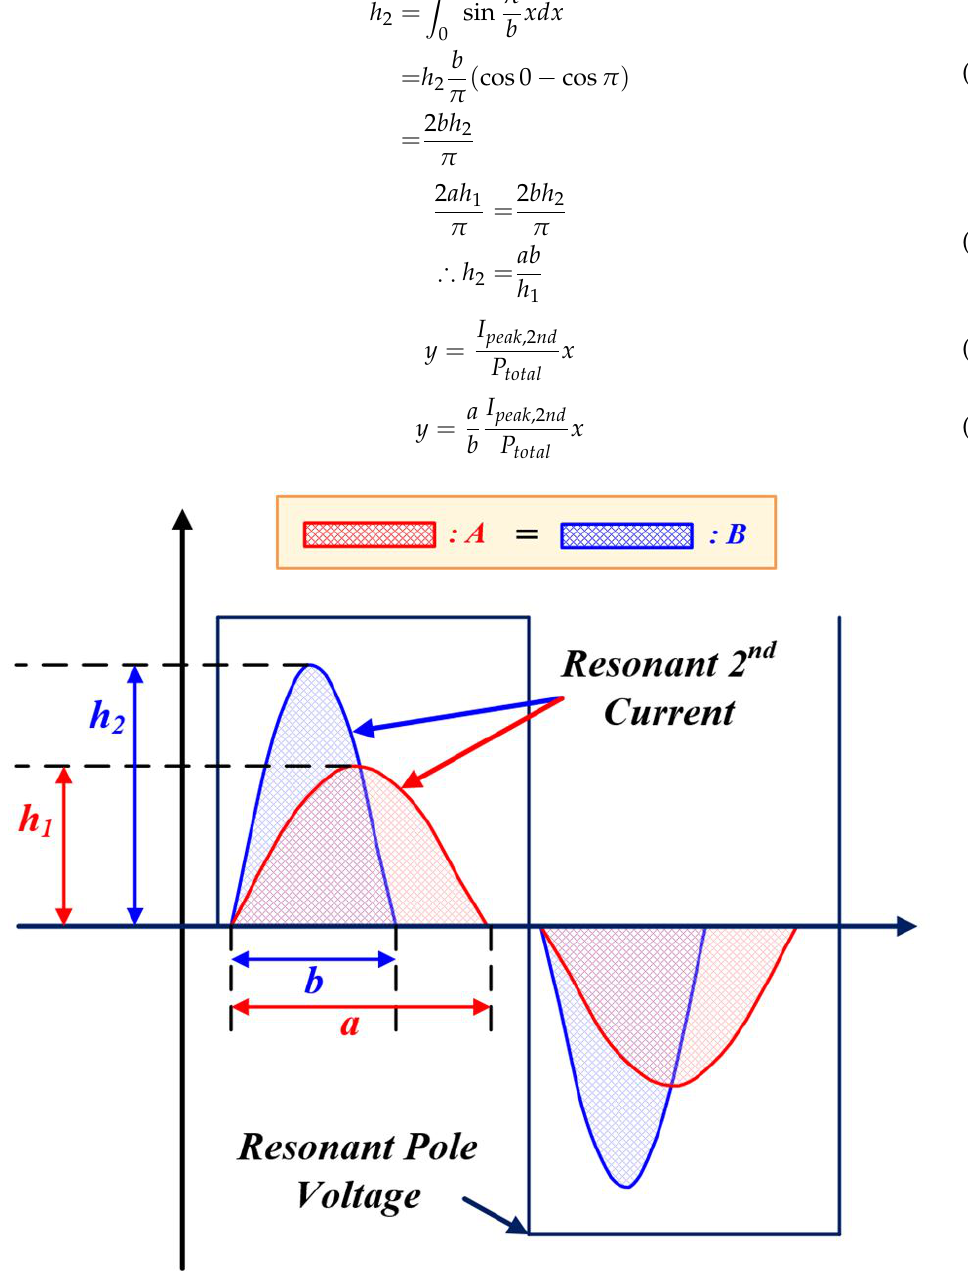
Figure 15. Control block diagram of the overall resonant auxiliary power supply